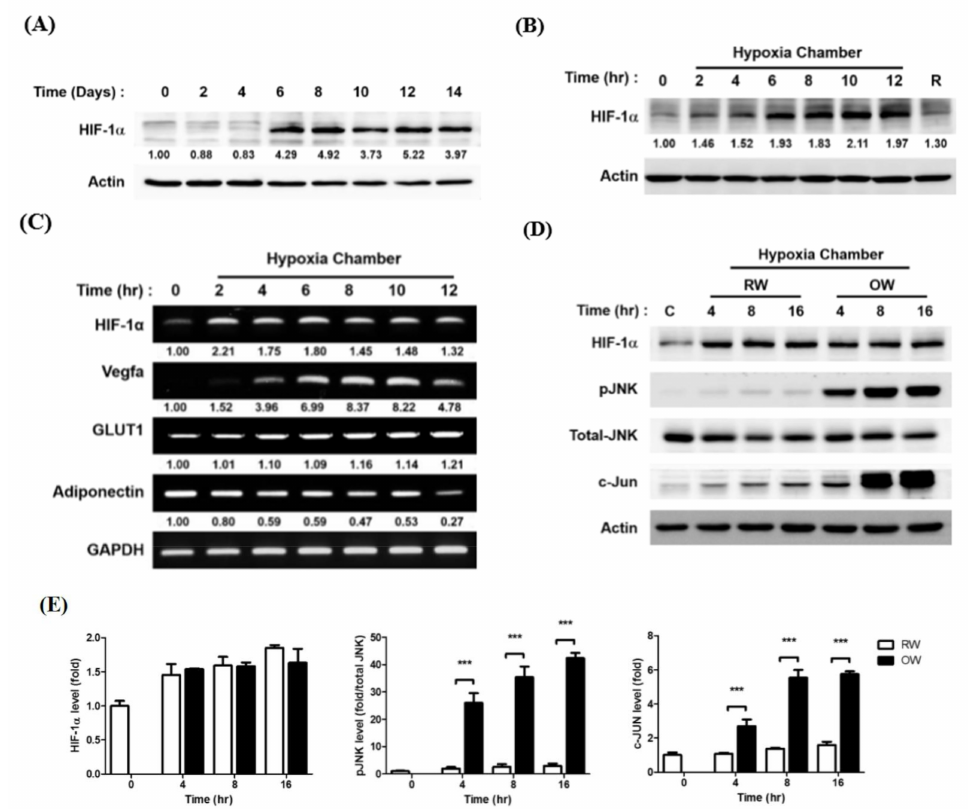
Figure 3. E ff ects of oxygenated water on hypoxia-induced HIF-1 α expression. ( A ) Temporal expression pattern of HIF-1 α protein during 3T3-L1 adipocyte di ff erentiation, examined by Western blotting. Temporal expression pattern of HIF-1 α proteins ( B ) and ( C ) mRNA after the di ff erentiated mature adipocytes were pre-incubated in serum-free medium for 3 h and exposed to 1% O 2 for di ff erent time intervals. R lane represents the cells being transferred back to normoxia (21% O 2 ) for 16 h after 8 h of hypoxia treatment. mRNAs of HIF-1 α downstream molecules were also examined ( C ). ( D ) Protein expression profiles of pro-inflammatory molecules after the mature adipocytes were pre-incubated in serum-free medium for 3 h, then exposed to 1% O 2 with either RW or OW for di ff erent time intervals were analyzed ( E ). Data are presented as mean ± S.E.M. ( n = 3) and were statistically analyzed by two-tailed unpaired Student t-tests, *** p <